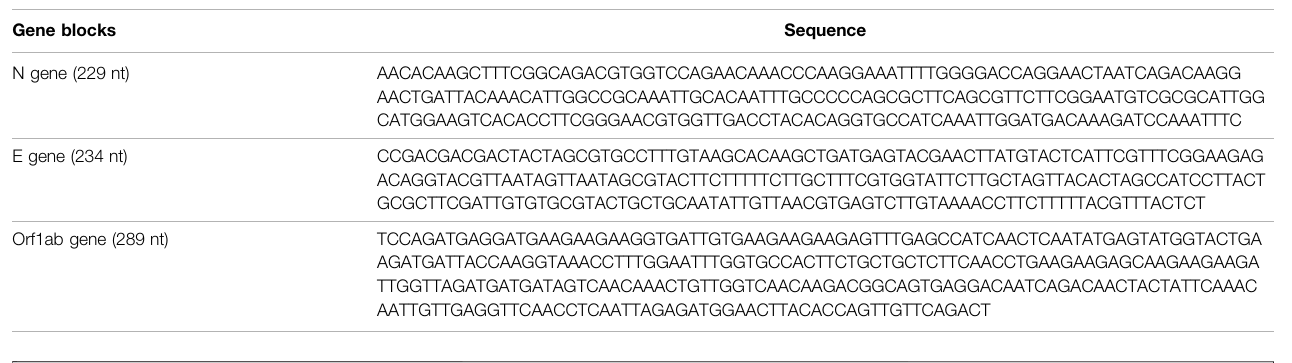
TABLE 4 | Sequences of N, E, and Orf1ab gene blocks.